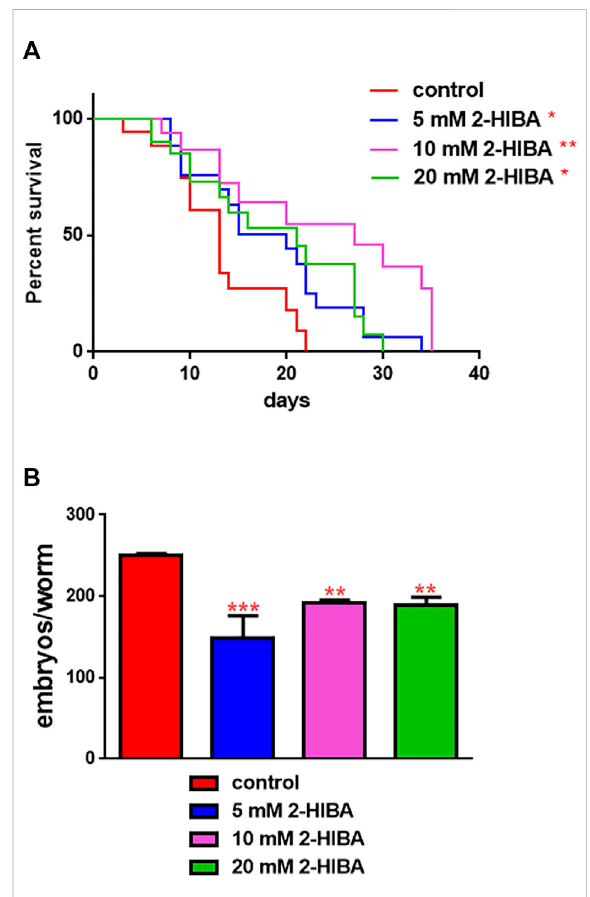
FIGURE 1 Impact of 2-HIBA on worm viability and fertility. (A) Kaplan – Mèier survival plot of N2 worms fed with heat-killed OP50 and supplemented with 5, 10 or 20 mM 2-HIBA. n = 60 for each data point of single experiments (* p < 0.05, ** p < 0.01). Lifespan assay was performed in triplicate and OP50-fed worms were taken as reference. (B) Average embryos production per worm of animals supplemented with different concentrations of 2-HIBA Bars represent the mean of three independent experiments; asterisks indicate the p -values (log-rank test) normalized to the control (** p < 0.01, *** p <